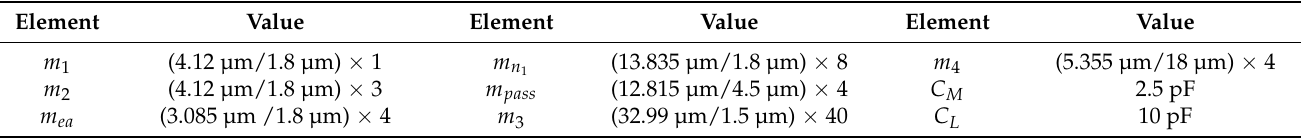
Figure 16. Location of the LDO voltage regulator inside the microphotography of the whole self- powered tag and a zoomed-in view of its layout. Table 5. Elements and transistor sizes of the LDO voltage